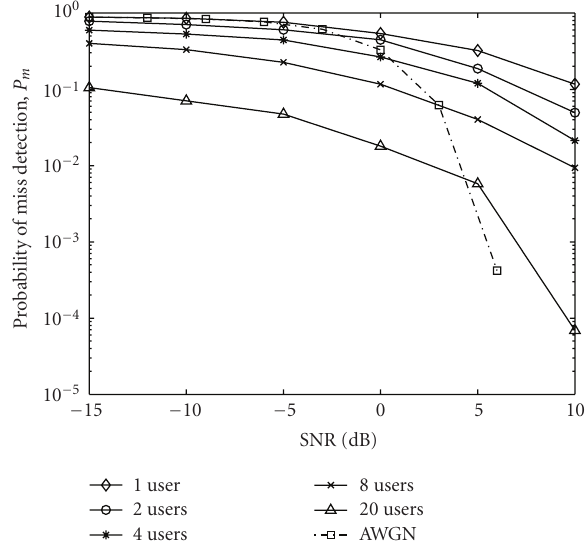
Figure 4: Receiver operating characteristics for collaborative spec- trum sensing under shadow fading, σ dB = 6, N = 5.